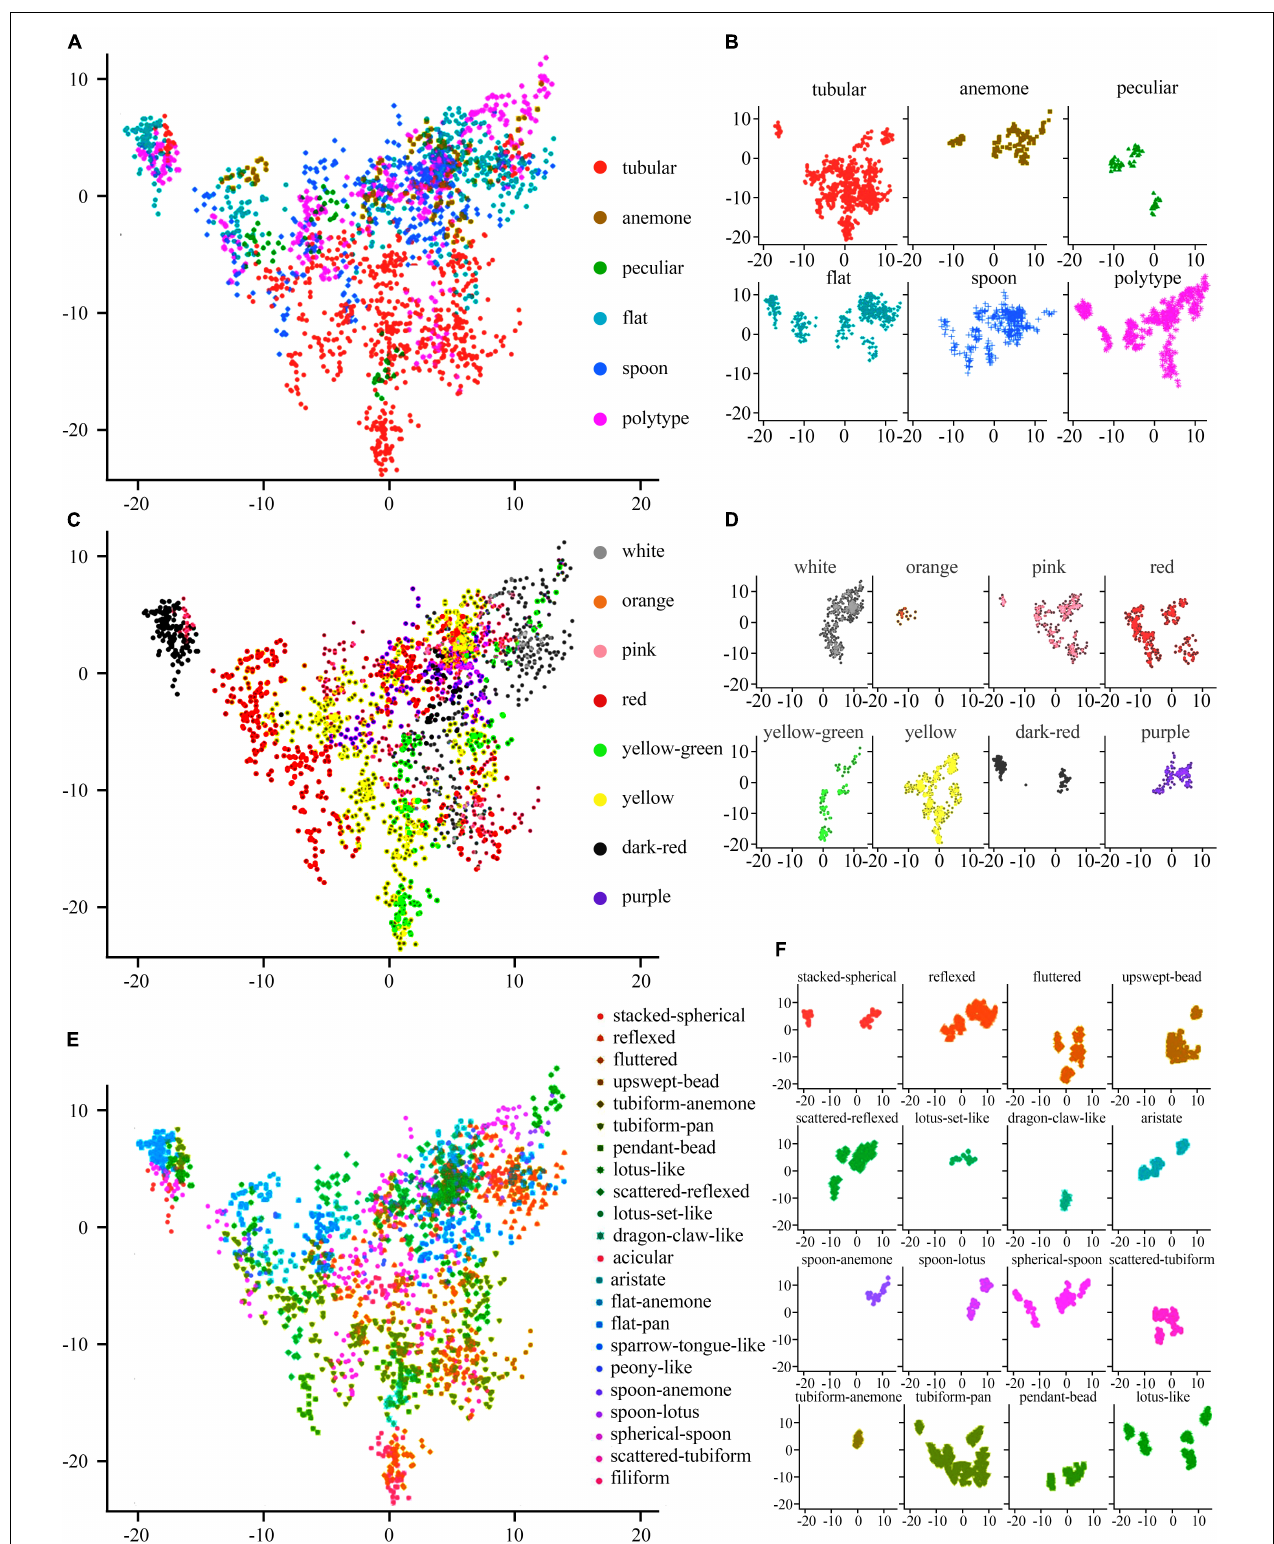
FIGURE 11 | Distribution of various flower colors, petal types, and flower types on the first two PCs. (A,C,E) The comprehensive distribution results of flower colors, petal types, and flower types, respectively. (B,D,F) The individual distribution results of flower colors, petal types, and flower types, respectively.